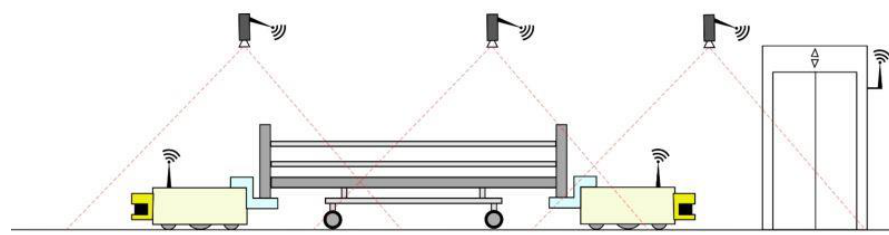
Figure 1. Layout of the use case “Autonomous Hospital Beds”.